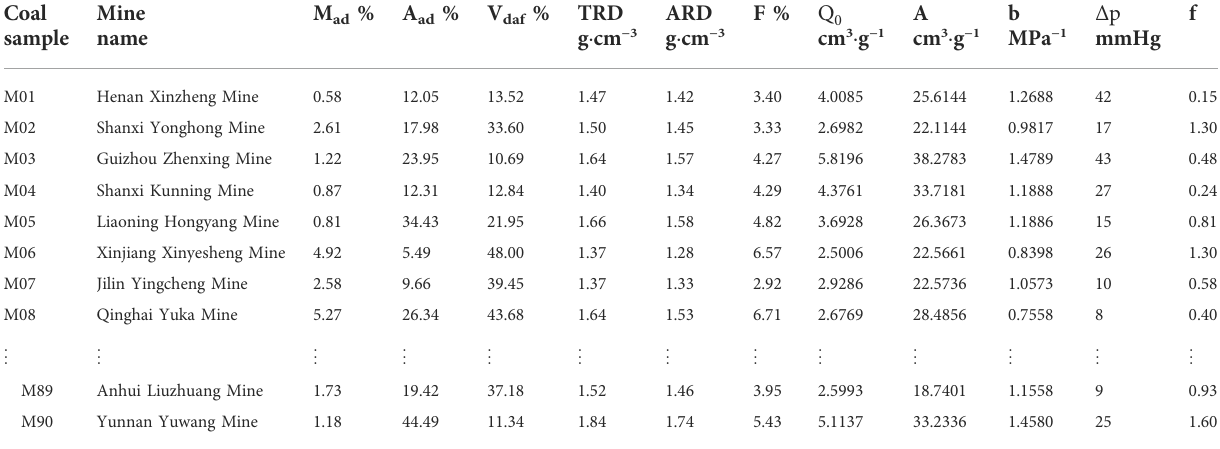
TABLE 1 Measured 90 coal sample coal quality index and gas basic parameters summary table